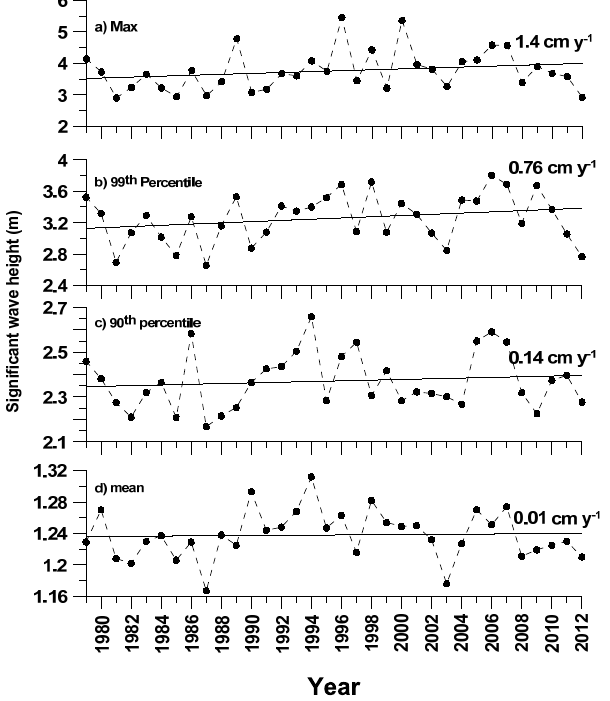
Figure 8. Long term trend in annual (a) maximum, (b) 99 th percentile, (c) 90 th percentile and (d) 472 Figure 8. Long-term trend in annual (a) maximum, (b) 99th per- centile, (c) 90th percentile and (d) mean significant wave height mean significant wave height during 1979-2012 473 from 1979 to 2012.